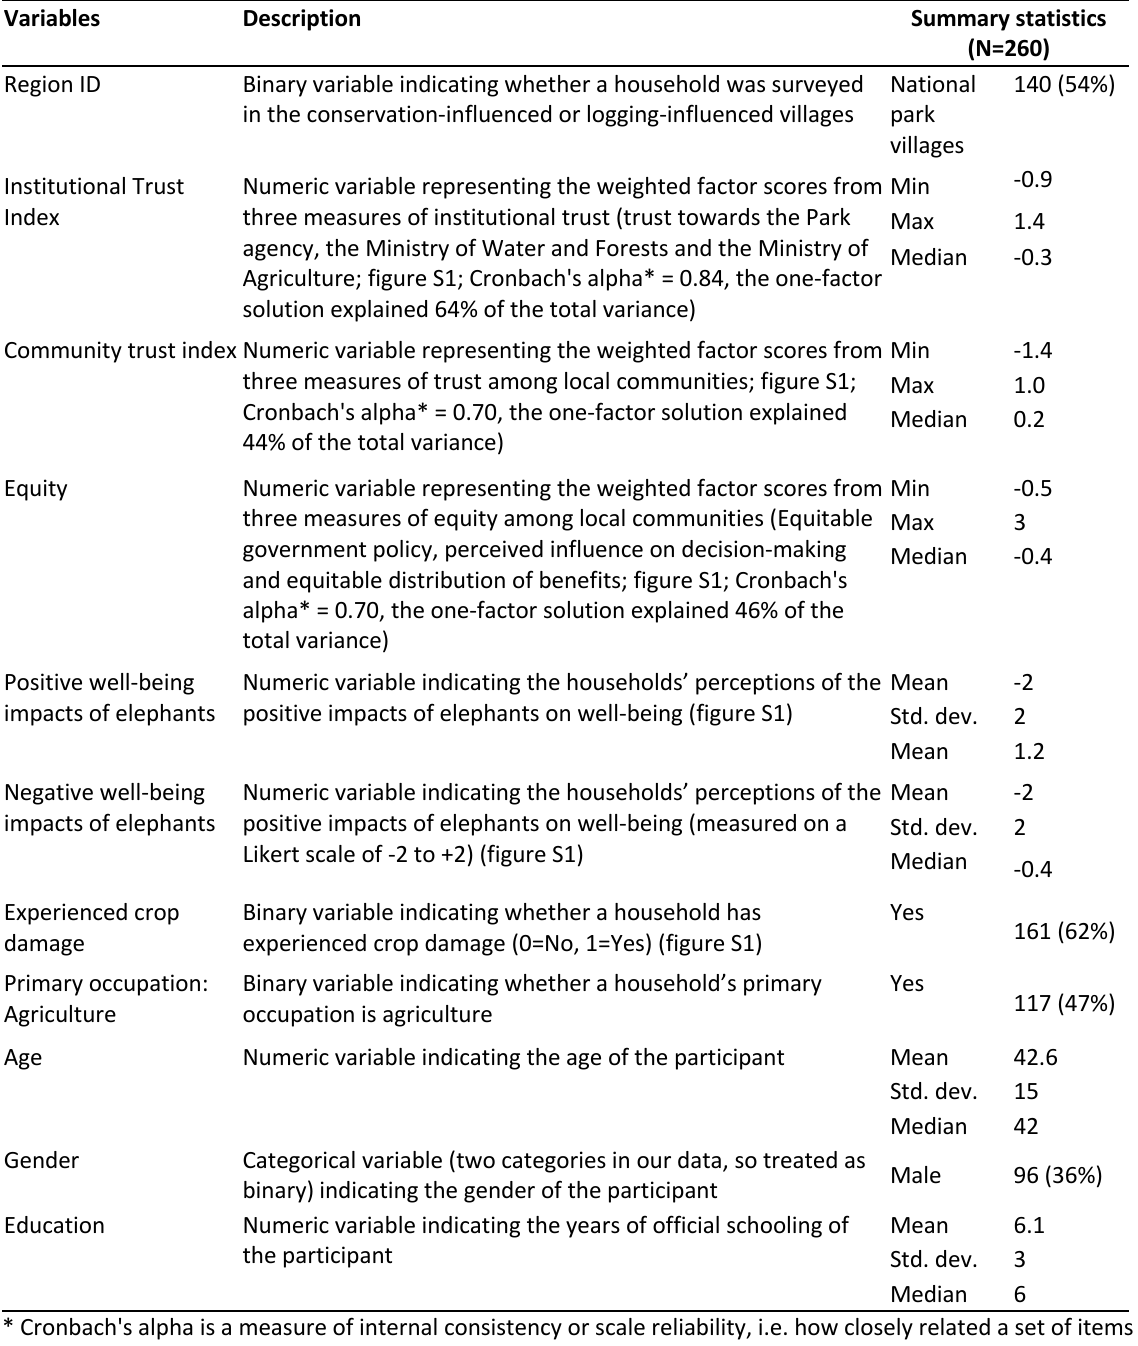
Table A1.2: Socio-economic and attitudinal variables included in the models